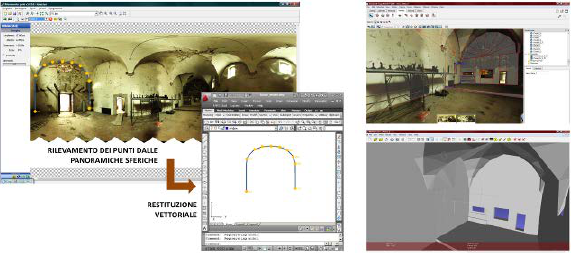
Figure 15. 3D models: extrapolation of spherical panorama vertices by spherical photogrammetry (right) and modelling using image modeler (left) (software: Create Point, Crea, Sphera, Image